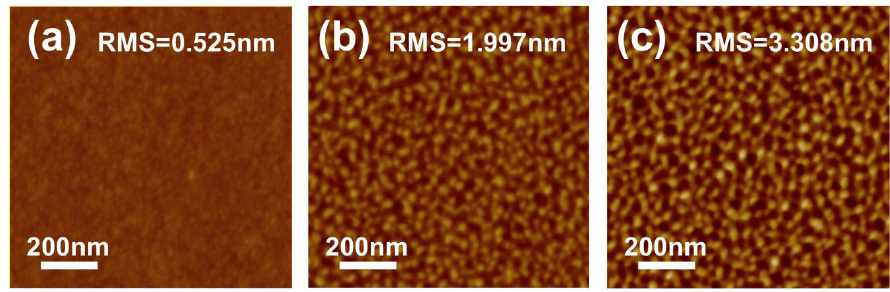
show a higher increase (345%) than those for 2